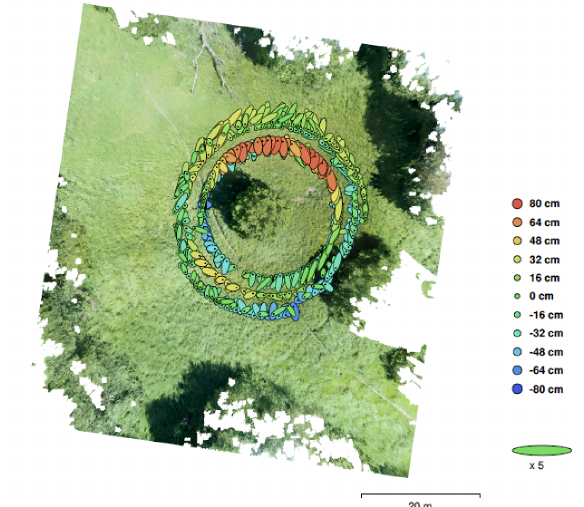
Figure 2. Image locations and relative error estimates in x/y directions measured for the POI image locations in three different height levels.